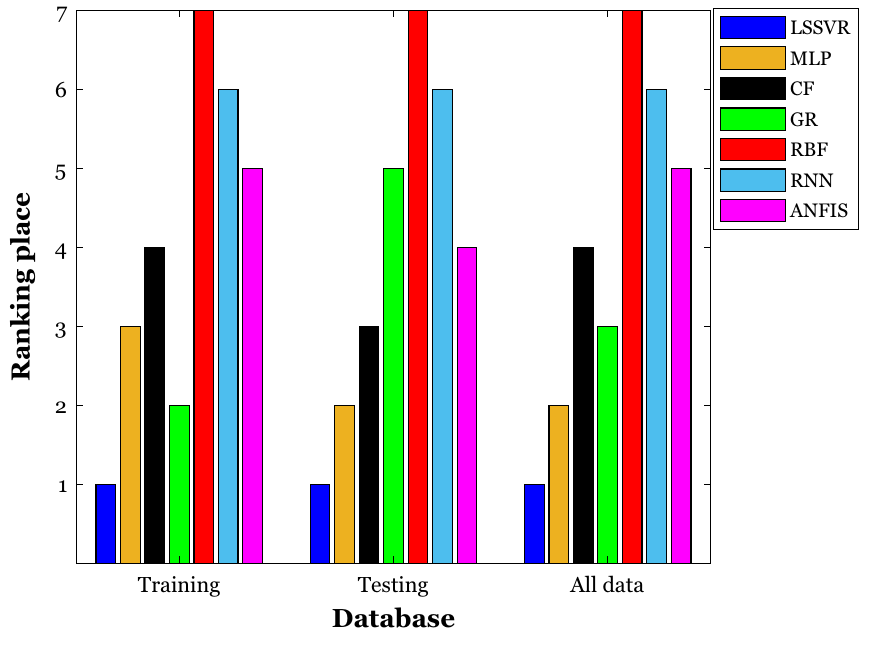
Figure 1. The ranking order of the intelligent estimators in different stages of the model